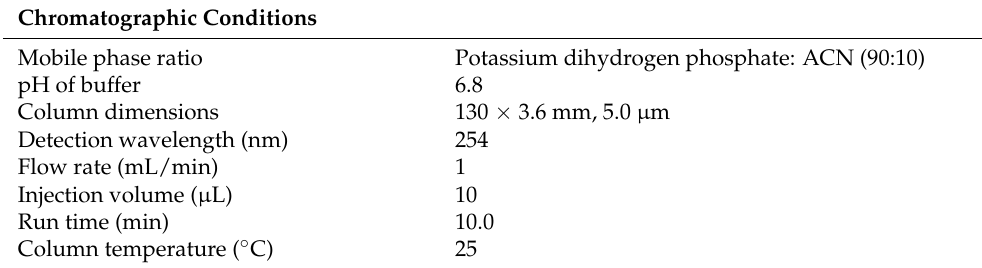
Table 5. Optimized chromatographic conditions for quantification of ACV in rat plasma samples. Chromatographic